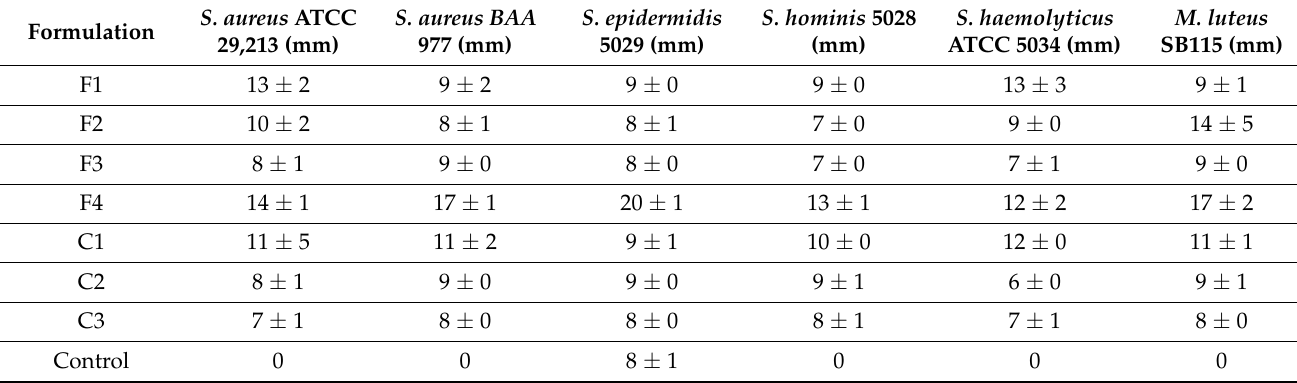
Table 6. The zone of inhibition diameters of the prepared hand sanitizers compared to three commercially available hand sanitizers (C1, C2, and C3) against gram-positive bacterial strains. The results represent the mean of three independent experiments ± SD ( n = 3). All EO hand sanitizers showed antibacterial activities against all gram-positive strains similarly to the controls, but with variable efficacies. The oil-free control formula showed no antibacterial effect against any of the tested gram-positive bacteria, except S. epidermidis .